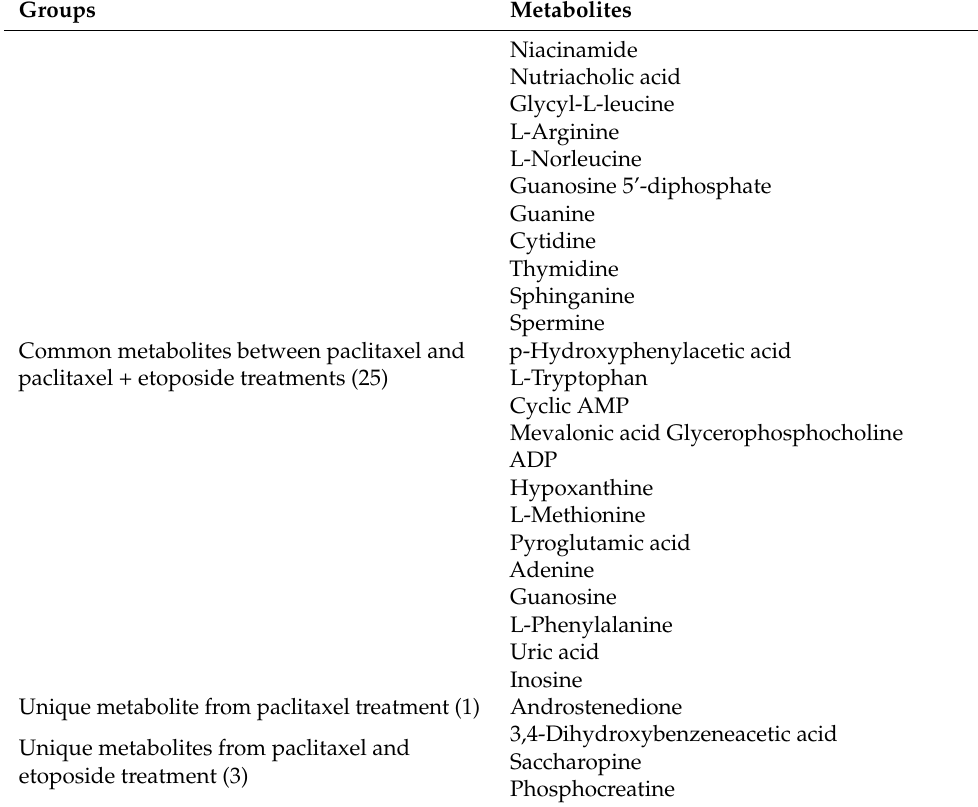
Table 2. Metabolites that responded to drug treatments according to Venn diagram comparison in U87 cell